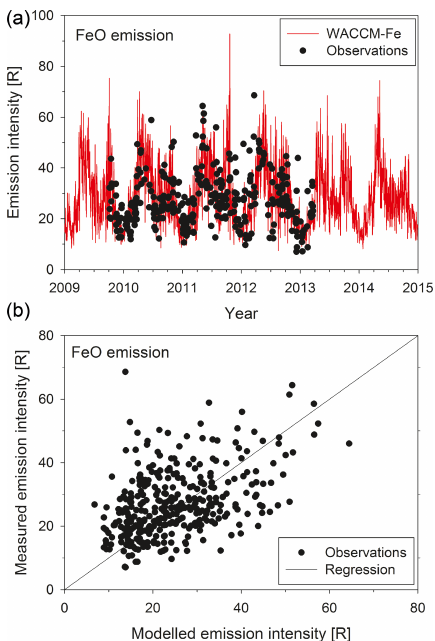
Figure 7. Comparison of the measured and modelled Na emis- sion intensity. (a) Absolute intensities over the period 2009–2015. (b) Correlation between the measured and modelled intensities. Note that the modelled intensities are scaled to produce a 1:1 re- gression line through the